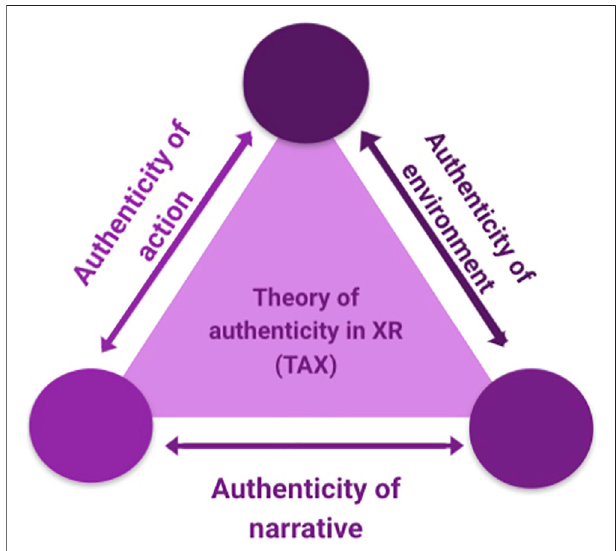
FIGURE 1 | The theory of authenticity in XR